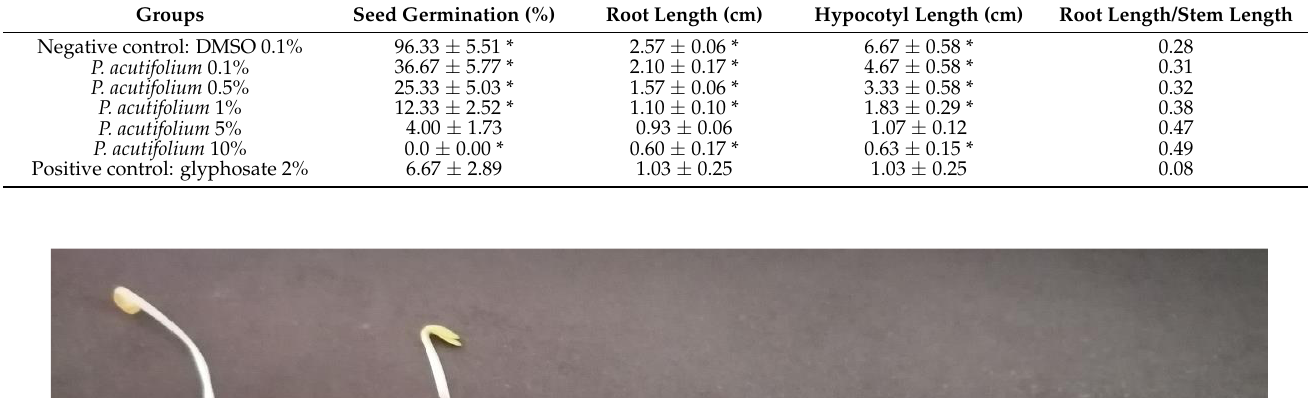
Table 3. Phytotoxic parameters evaluated on Lactuca sativa seeds. Values are expressed as mean ± SD. Groups are compared with the positive control, * ( p < 0.001).